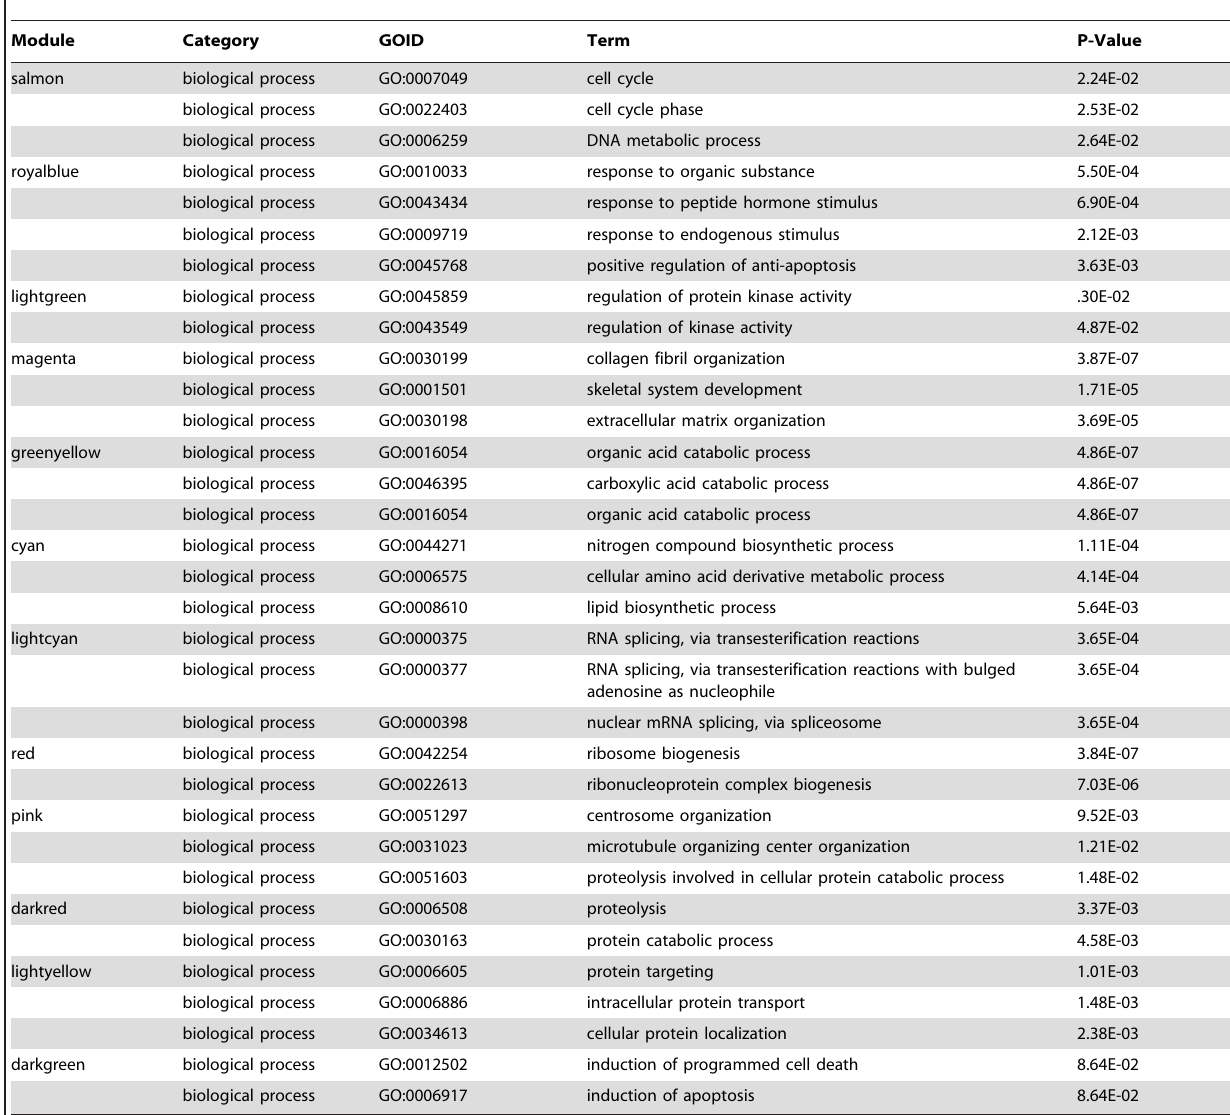
Table 1. Top-ranked functional annotations enriched in LR-related